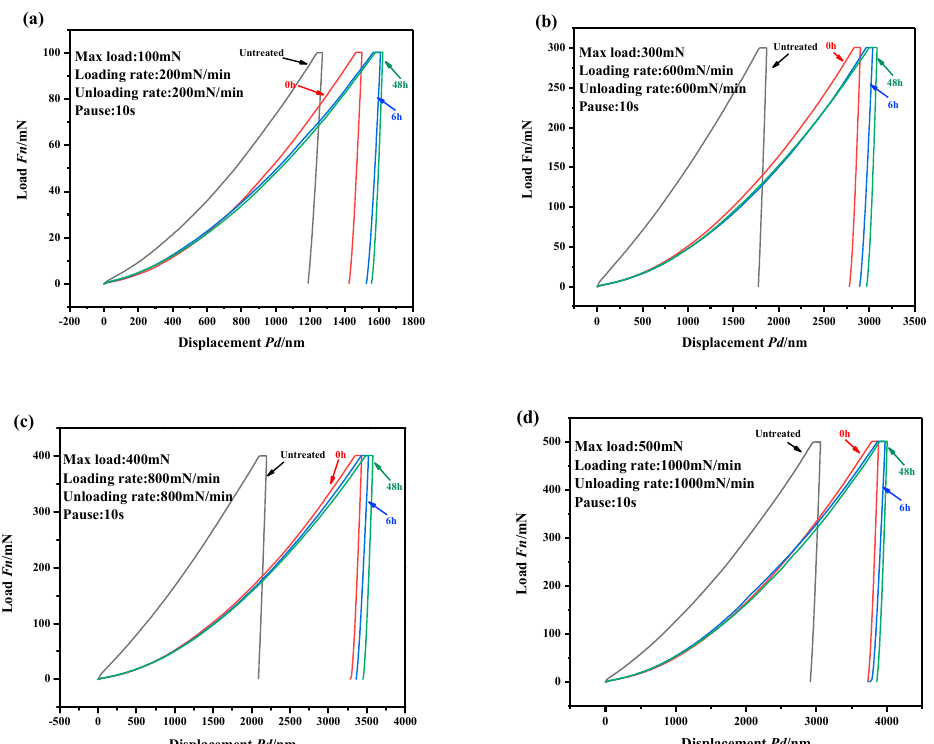
Figure 7. Force-displacement curves for different loads: ( a ) maximum indentation load is 100 mN, ( b ) maximum indentation load is 300 mN, ( c ) maximum indentation load is 400 mN, ( d ) maximum indentation load is 500 mN.